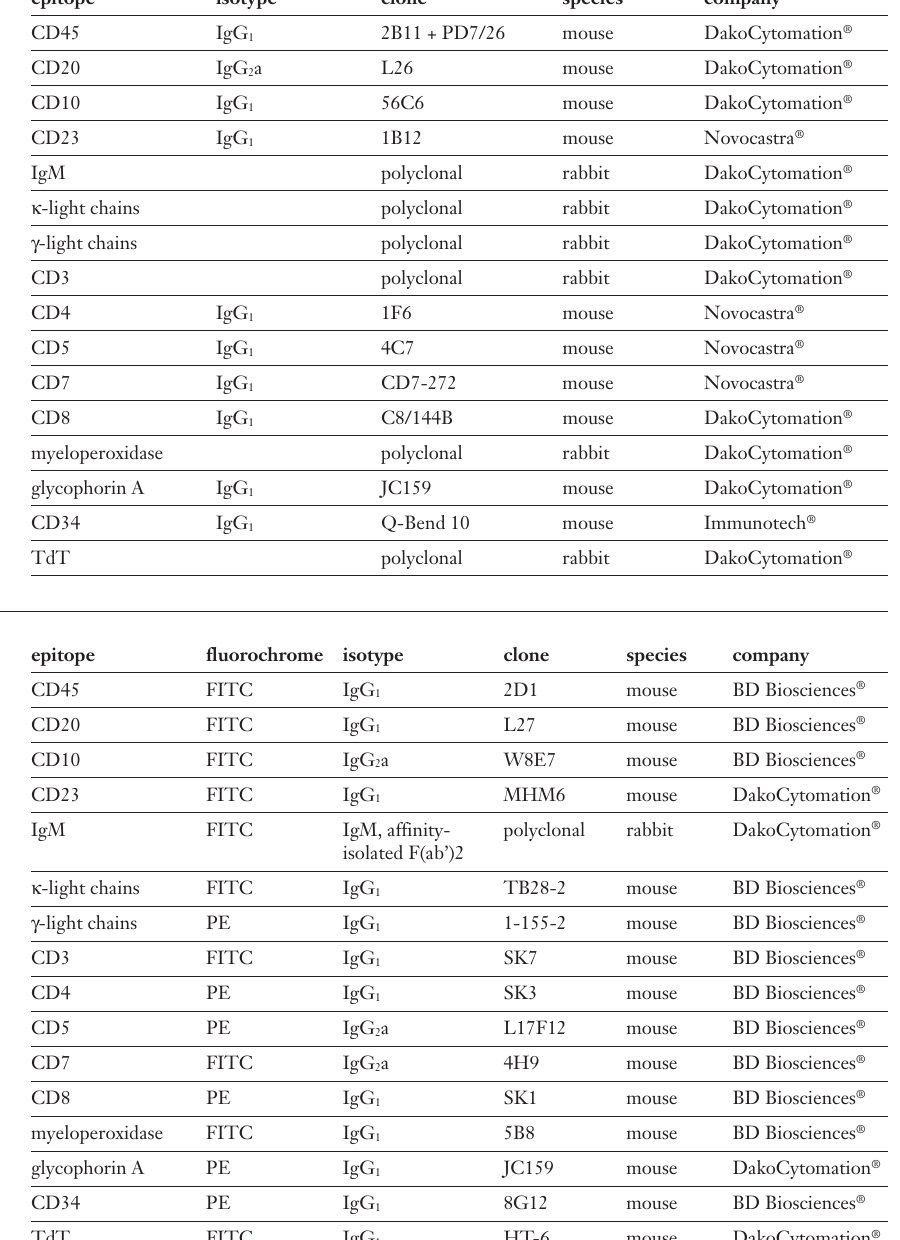
Specifications of antibodies used for immunophenotyping with the PAP method (TdT = terminal deoxynucleotidyl transferase).